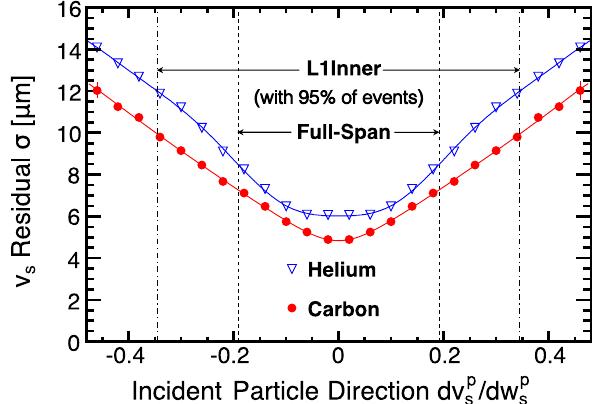
Fig. 29 The rigidity resolutions, σ( 1 / R ), of L1-inner ( R = R 18 ) and full-span ( R = R 19 ) track patterns as functions of the true rigidity for carbon nuclei obtained from MC simulation. The corresponding = maximal detectable rigidities, R M , with R M σ( 1 / R M ) ≡ 1 , are R M 18 = 3 . 6 1 . 6 TV and R M 19